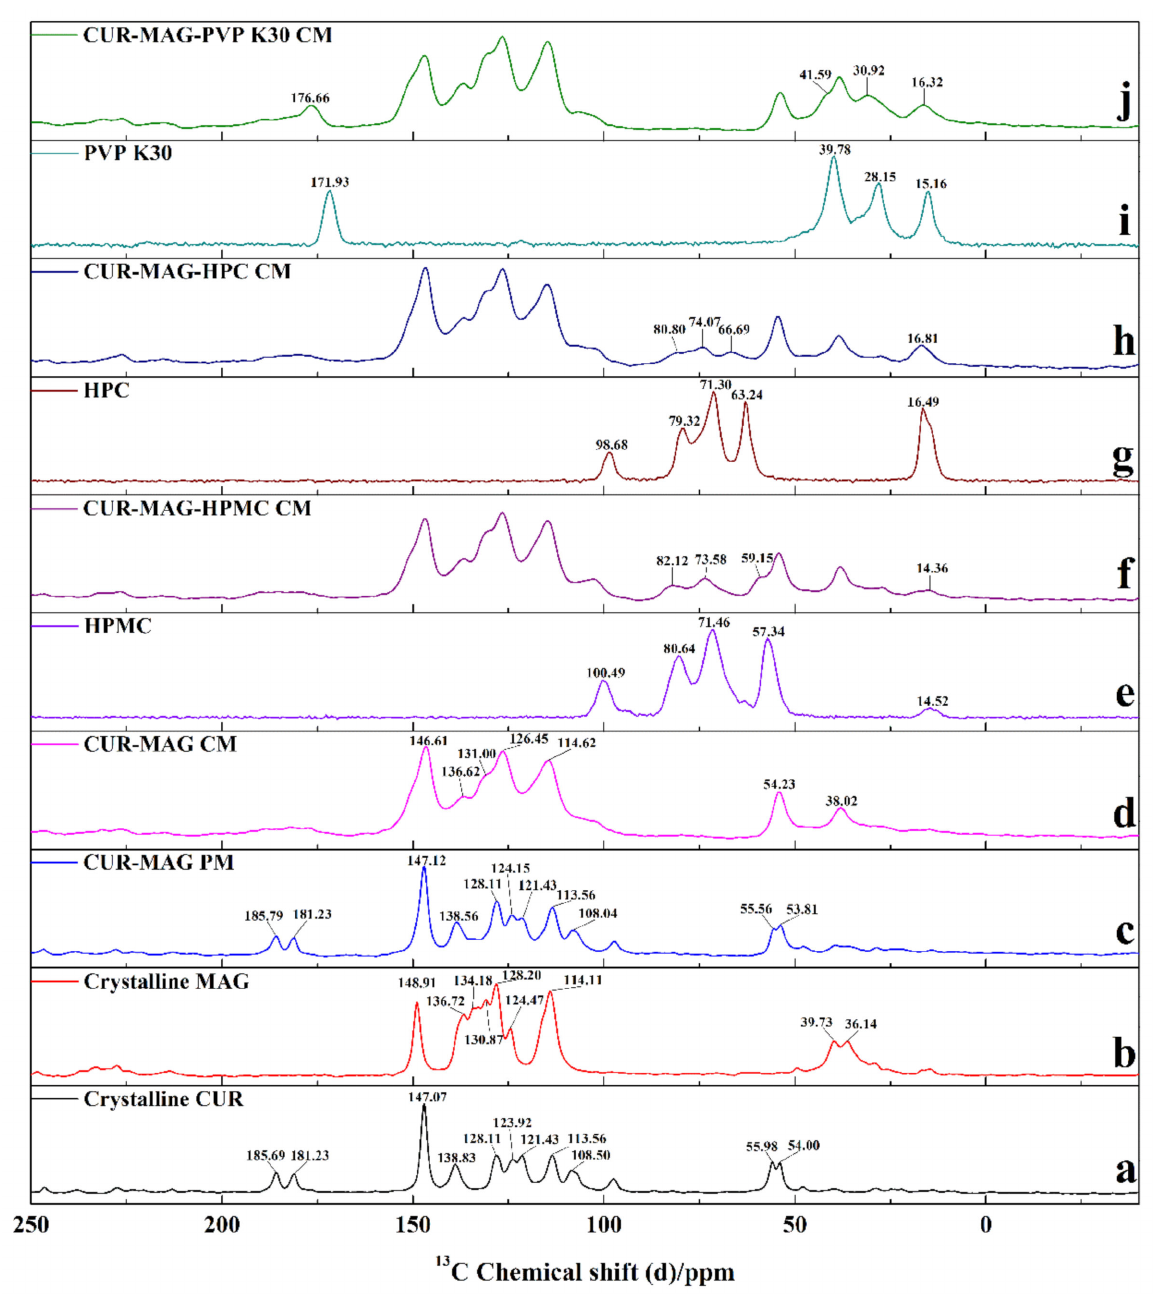
Figure 6. ss 13 C NMR spectra: ( a ) crystalline CUR; ( b ) crystalline MAG; ( c ) CUR-MAG PM; ( d ) CUR-MAG CM; ( e ) HPMC; ( f ) CUR-MAG-HPMC CM; ( g ) HPC; ( h ) CUR-MAG-HPC CM; ( i ) PVP K30; ( j ) CUR-MAG-PVP K30